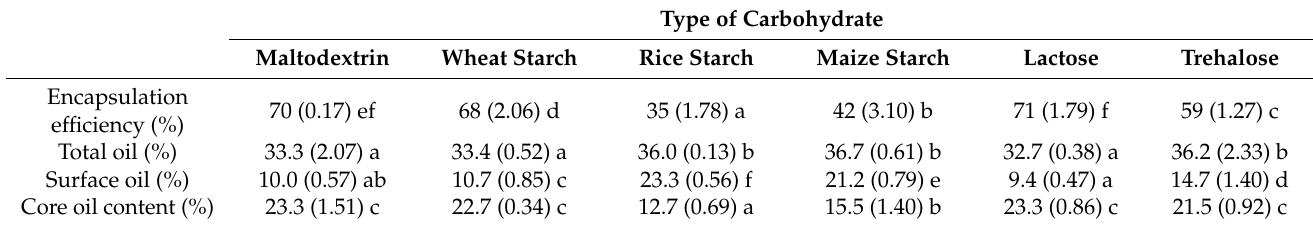
Table 2. Oil content in capsules and encapsulation efficiency of spray drying process of pumpkin oil with carbohydrate materials.